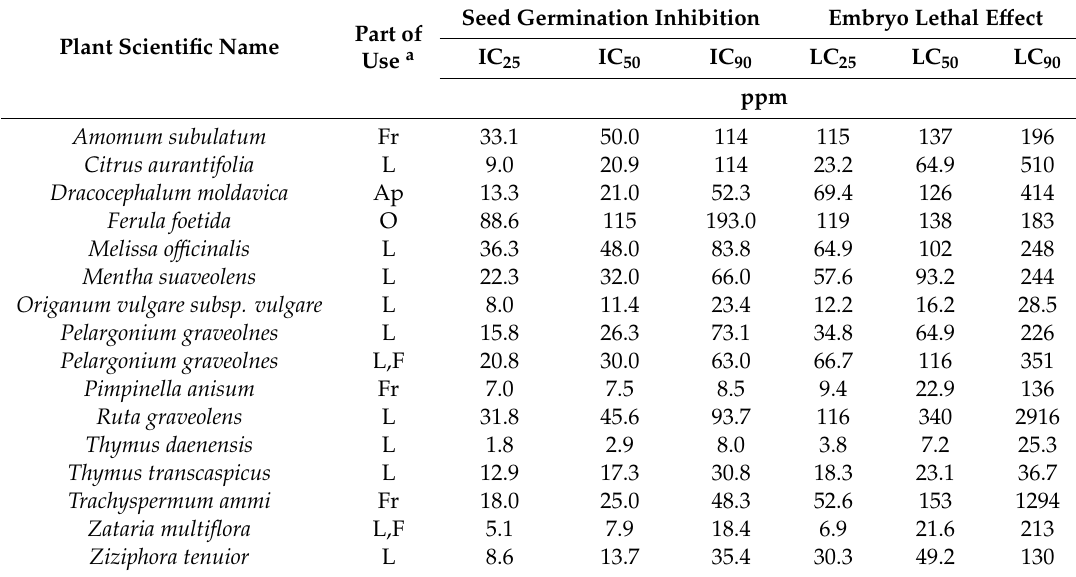
Table 3. The e ff ective concentration of EOs on seed germination inhibition and embryo lethal by cotton swab method.